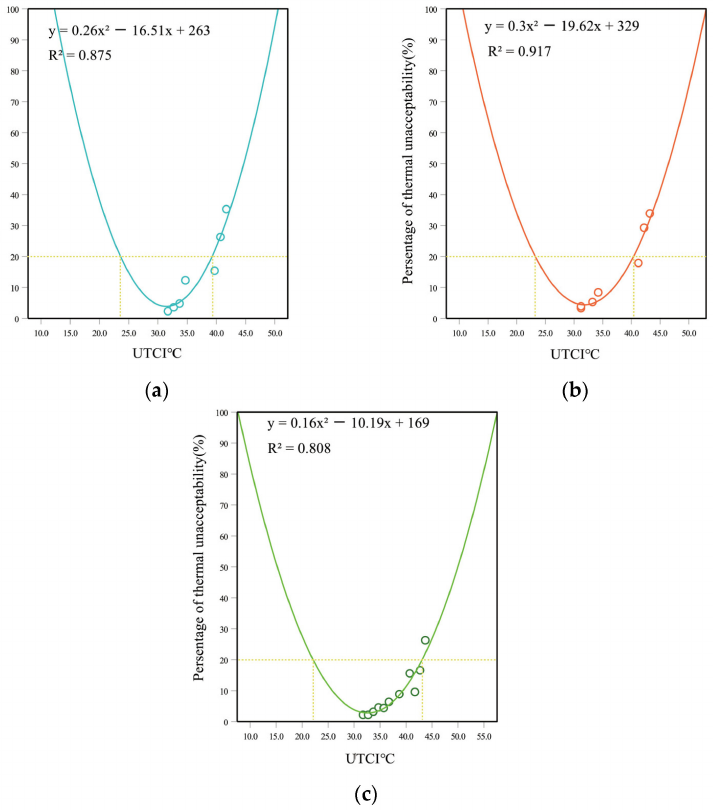
Figure 10. Relationship between the thermal unacceptable rate and UTCI: male ( a ), female ( b ) and all respondents ( c